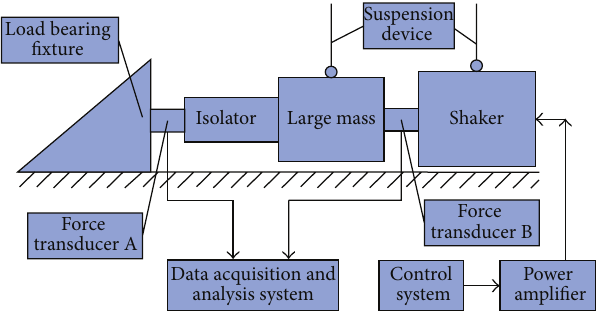
Figure5:Theschematicdiagramofthetestsetupofhystereticloops.